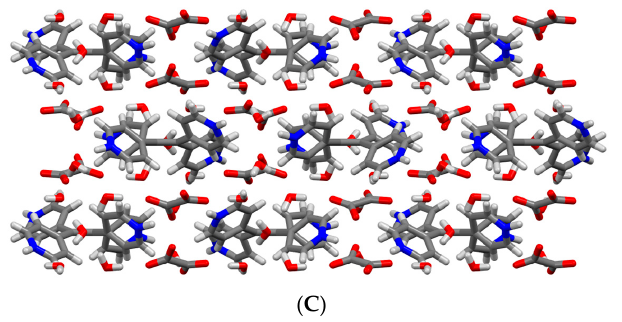
Figure 3. ( A ) Tetrameric water clusters linking oxalate ions in 7 (oxalic acid) 2 7H 2 O. ( B , C ) Two views of the extended packing in 7 (oxalic acid) 2 7H 2 O: ( B ) down c ; ( C ) down b .